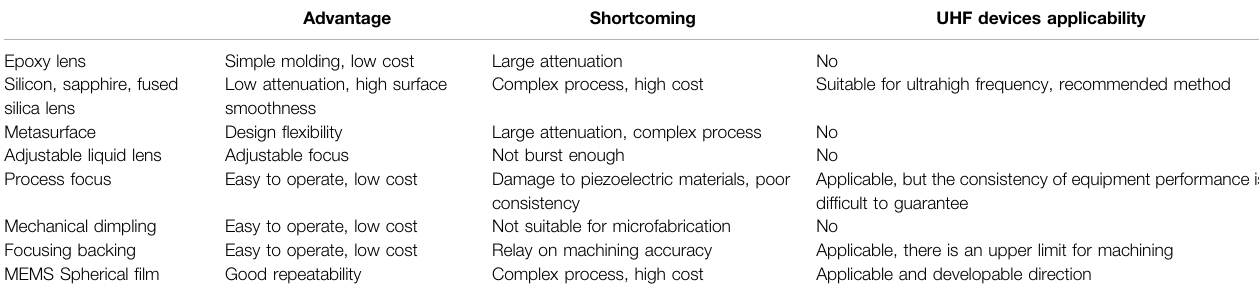
TABLE 5 | Summary of focusing